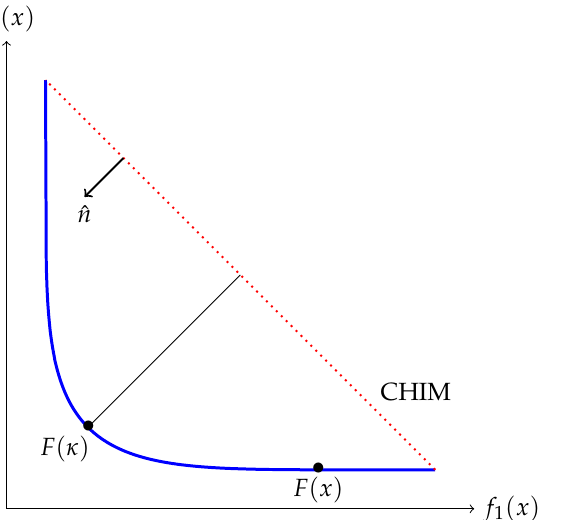
Figure 1. Pareto front of a hypothetical bi-objective problem with knee solution κ